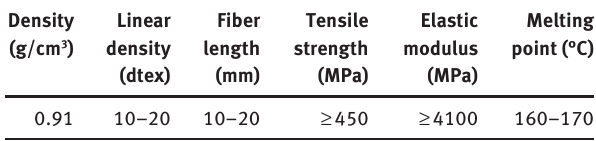
Table 2 Physical properties of polypropylene fiber.